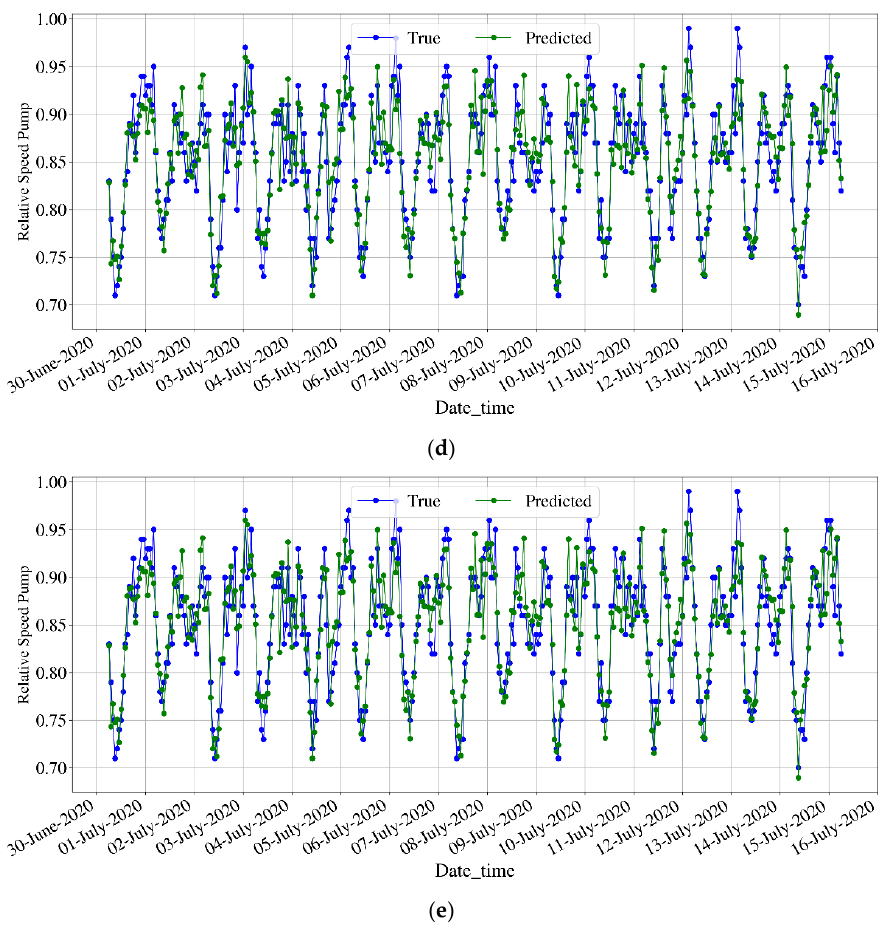
Figure 6. Comparison curve of model predicted values and real values of the relative pump speeds for Network 2. ( a ) PU2, ( b ) PU4, ( c ) PU6, ( d ) PU8, ( e ) PU10.